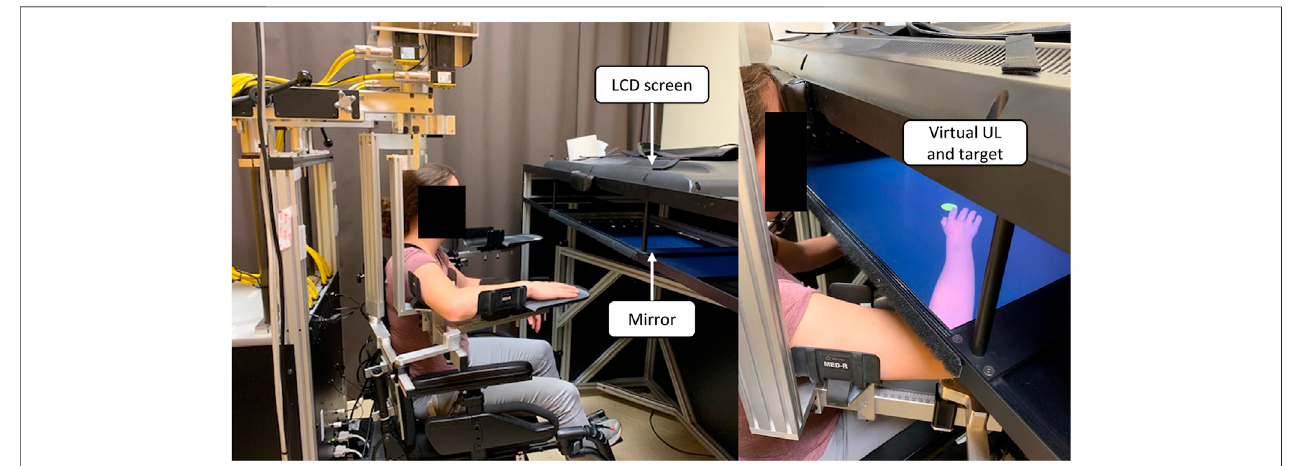
FIGURE2| KINARMset-upandvirtualupperlimb(UL).ThemirrorallowsthevirtualULtobedisplayedataproperdepthsothatitreplacesone ’ srealUL.Duringthe experiment, a bib was worn to prevent participants from seeing their proximal UL (not shown in the picture).